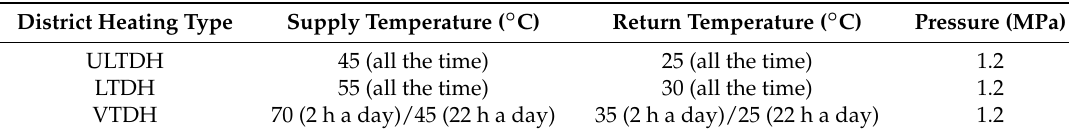
Table 3. Characteristics of the three district heating